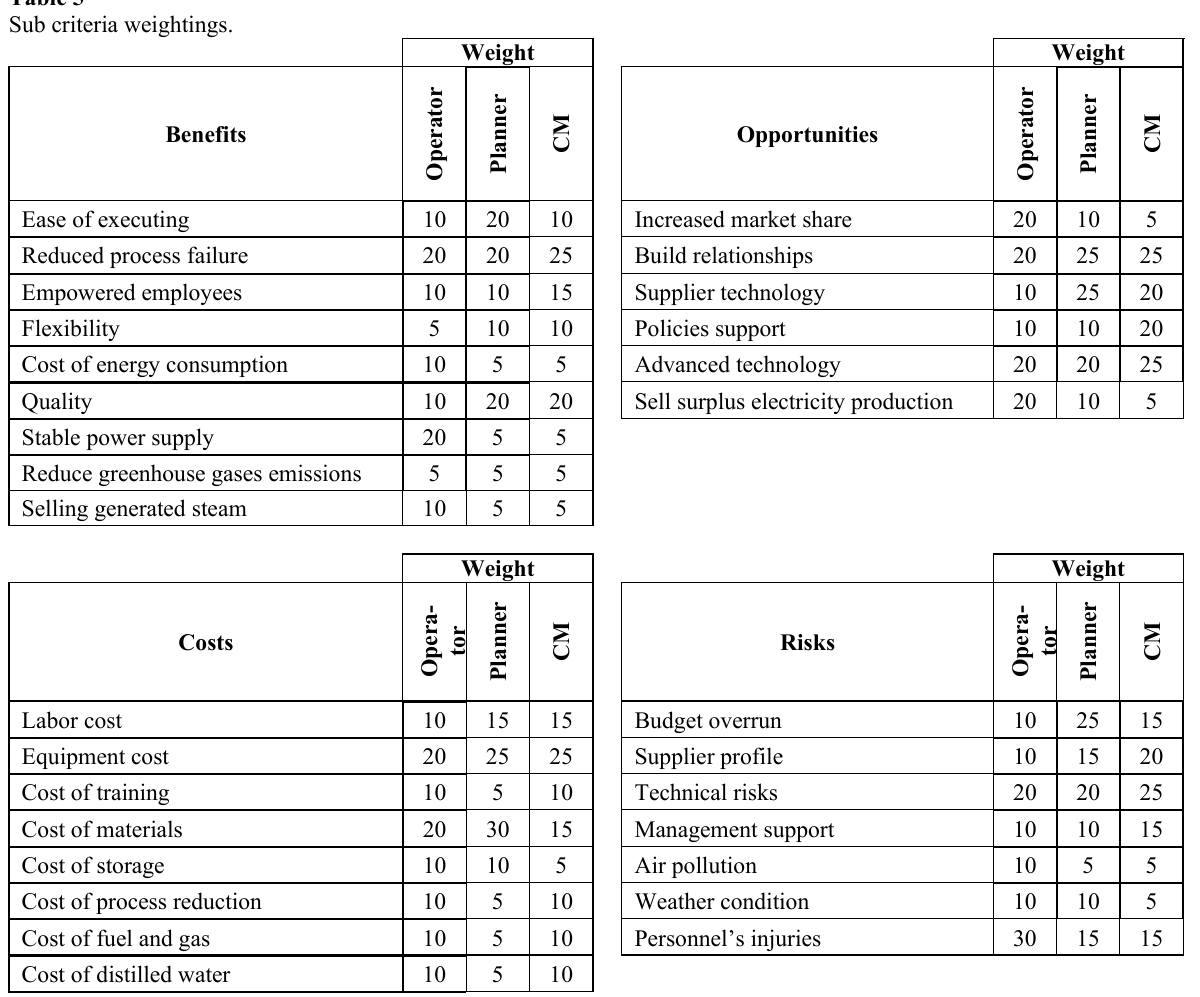
Fig. 3 to Fig. 6 in following, will show the hierarchy charts of evaluated sub criteria and maintenance alternatives that are done by